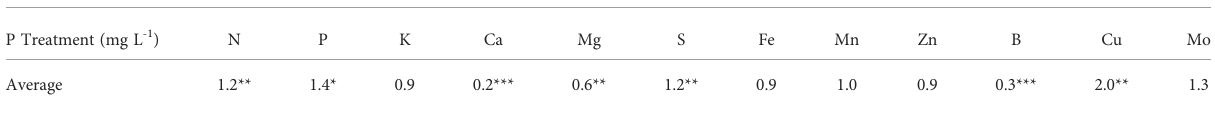
Flower to leaf ratio for tissue elements